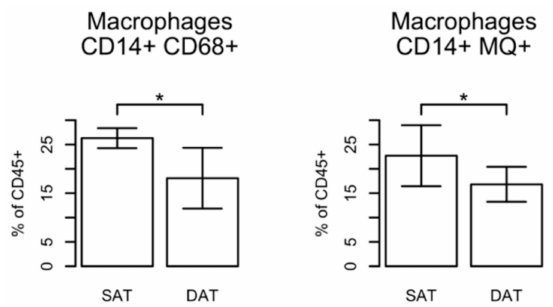
Figure 6. Macrophage infiltration in SAT and DAT. Gating strategy is shown in Figure 4A. Macrophages (defined as CD14 + CD68 + or CD14 + M Φ + (clone 25f9)) are shown as % of CD45 + cells. Results represent data from four patients and are expressed as mean ± SD. Significance of the difference in means was calculated using a paired t -test (* p -value <